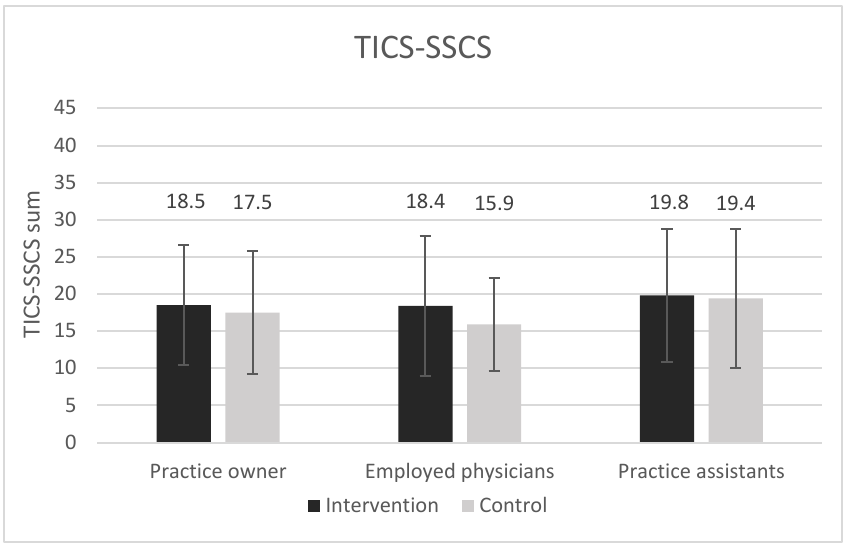
Figure 5. TICS-SSCS sum scores of practice owners, employed physicians and practice assistants are shown for study arms. Error bars show standard deviations. All presented differences between in- tervention and control group are non-significant ( p > 0.05).